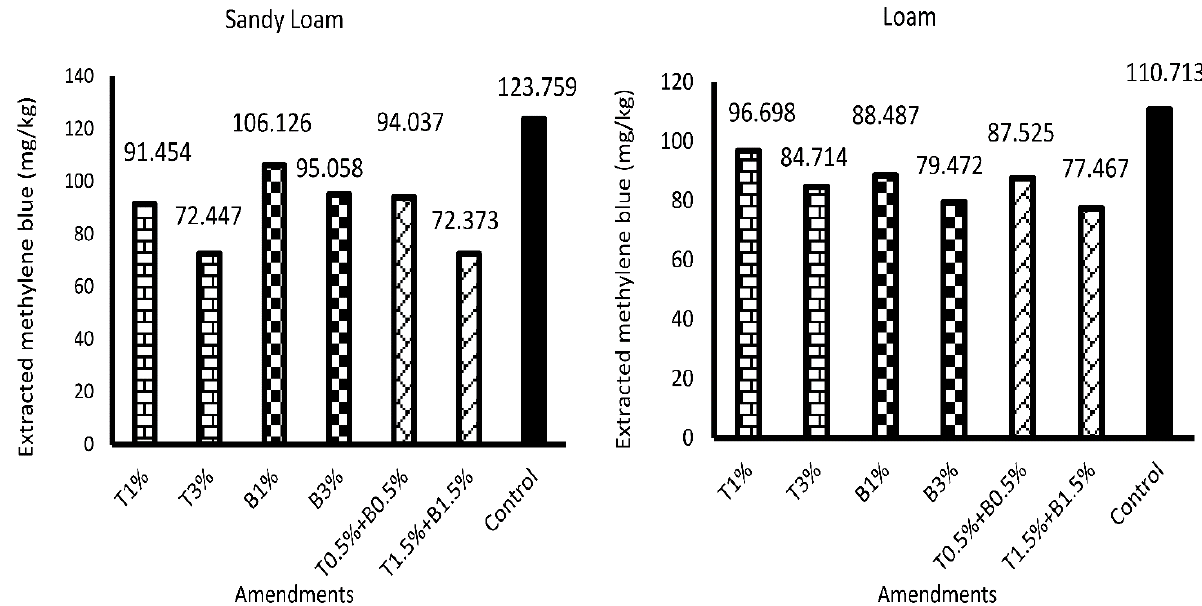
Fig. 3. Effects of various levels of T and B on extracted MB from SL and L soils (each column: mean of 18 samples; different letters indicate significant differences in means of different treatments;